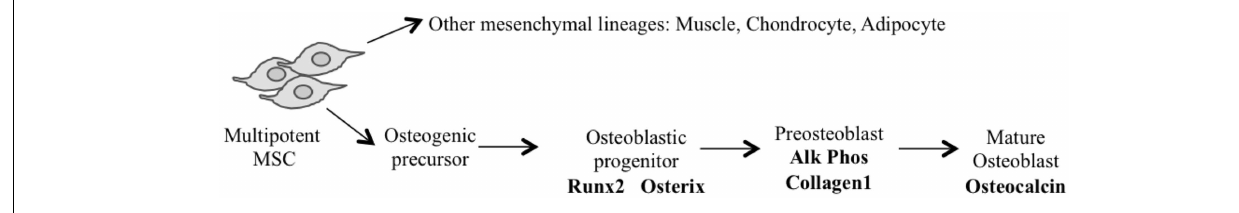
FIGURE 1 | Model of osteoblast differentiation and putative stage of Cre expression is shown .